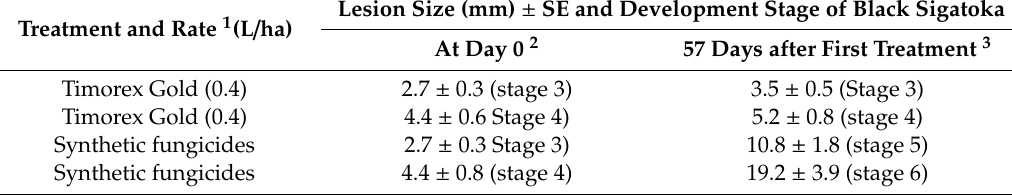
Table 1. Curative activity of Timorex Gold against M. fijiensis in banana leaves.